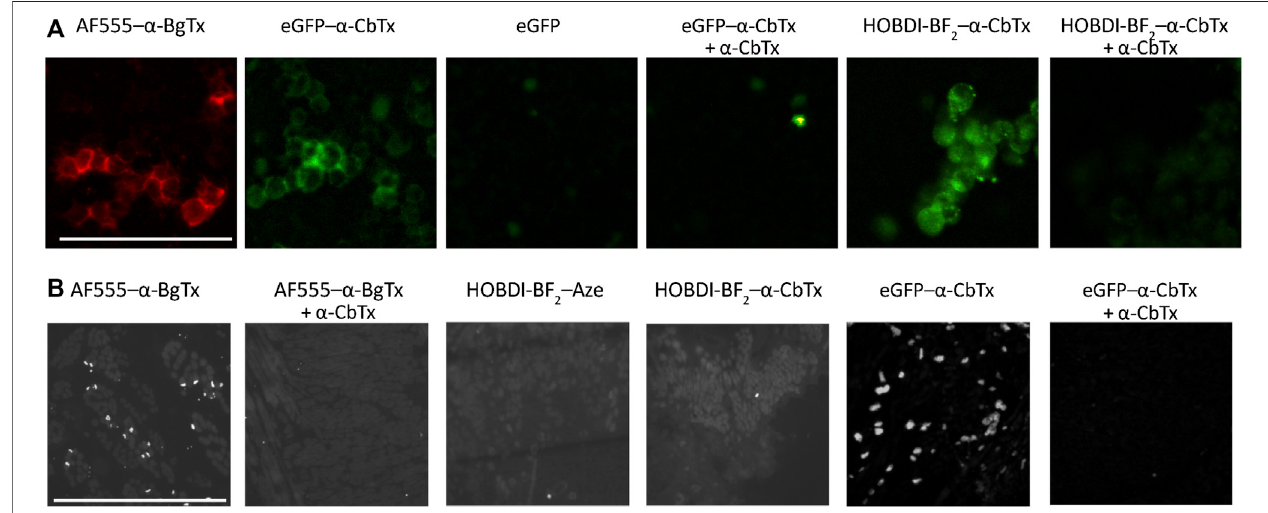
FIGURE 6 | Fluorescence microscopy of Neuro-2a cells transfected with human α 7 nAChR, and rat tongue preparation containing muscle fi ber end plates with muscle α 1 β 1 εδ nAChR. (A) Control staining of Neuro-2a cells with 50 nM AF555 – α -BgTx shows peripheral staining of the cells, which is reproduced by the eGFP – α - CbTx chimeric protein (500 nM). eGFP alone does not stain the cells. Complementary to that, speci fi c eGFP – α -CbTx staining is abolished by 1 h preincubation with 15 µM α -CbTx. HOBDI-BF 2 – α -CbTx (100 nM) also stains Neuro-2a cells, and it is prevented by 1 h pre-treatment using 5 µM α -CbTx. Scale bar in the fi rst panel, 50 μ m. (B) AF555 – α -BgTx (100 nM) speci fi cally stains end plates in rat tongue cross-sections, and no staining is observed in cross-sections pre-treated with 5 µM α -CbTx. Neither HOBDI-BF – α -CbTx, nor HOBDI-BF – Aze produce end plate staining, whereas 500 nM eGFP – α -CbTx chimeric protein (12 h of incubation) stained 2 2 cross-sections brightly. End-plate staining by eGFP – α -CbTx chimeric protein is prevented by 1 h pre-treatment with 15 µM α -CbTx. Scale bar in the fi rst panel, 50 μ